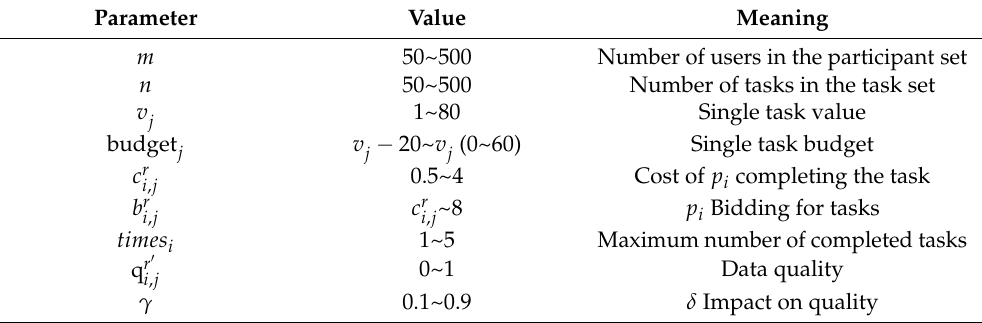
Table 2. Experimental